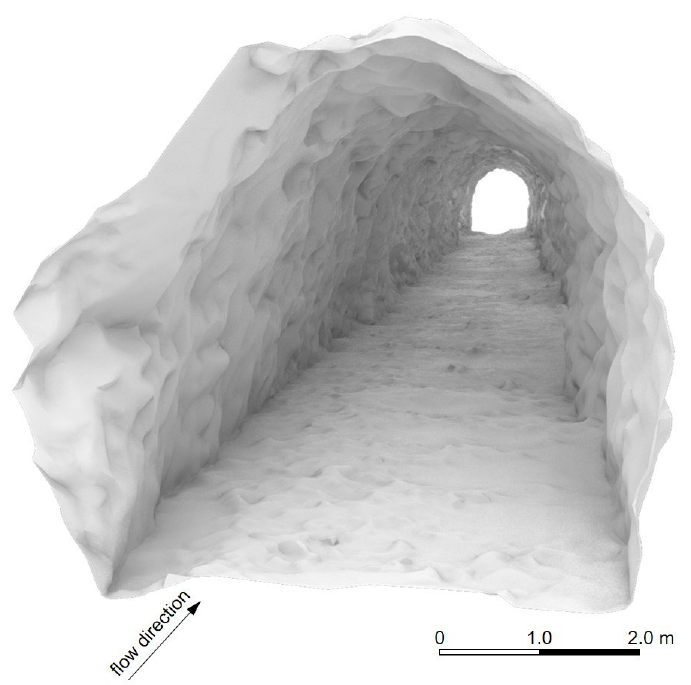
Figure 1. Visualization of a scanned tunnel section of the Litjfossen hydropower plant in Norway.